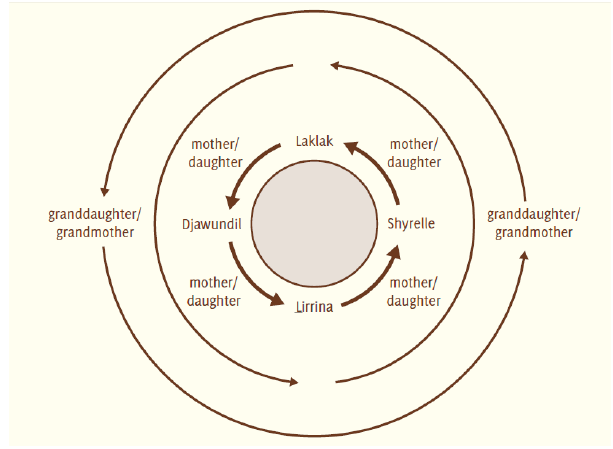
Figure 2. Basic Gurrutu cycle of Laklak and daughters ([1], p. 147).